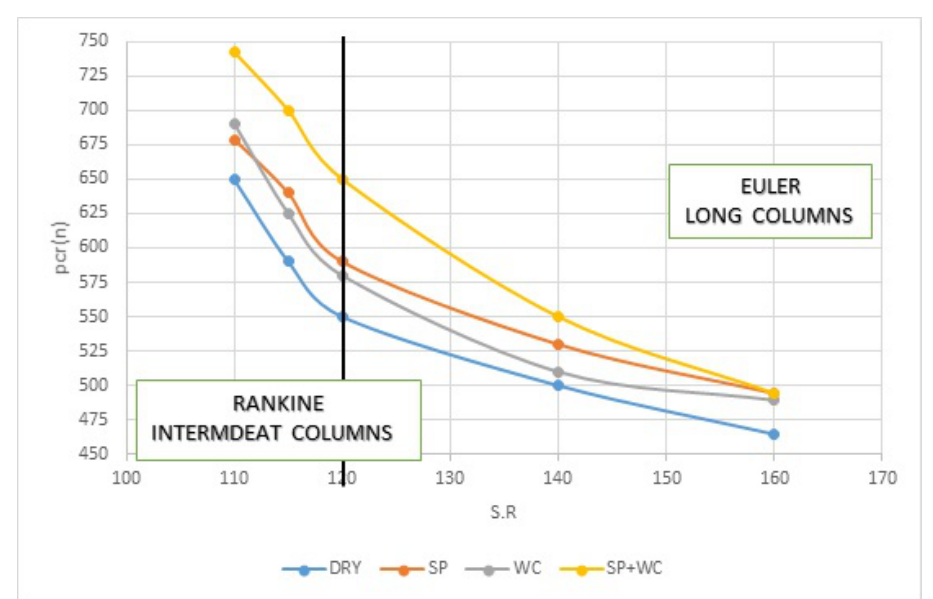
Figure 4: Euler and Rankine buckling results for long and intermediate